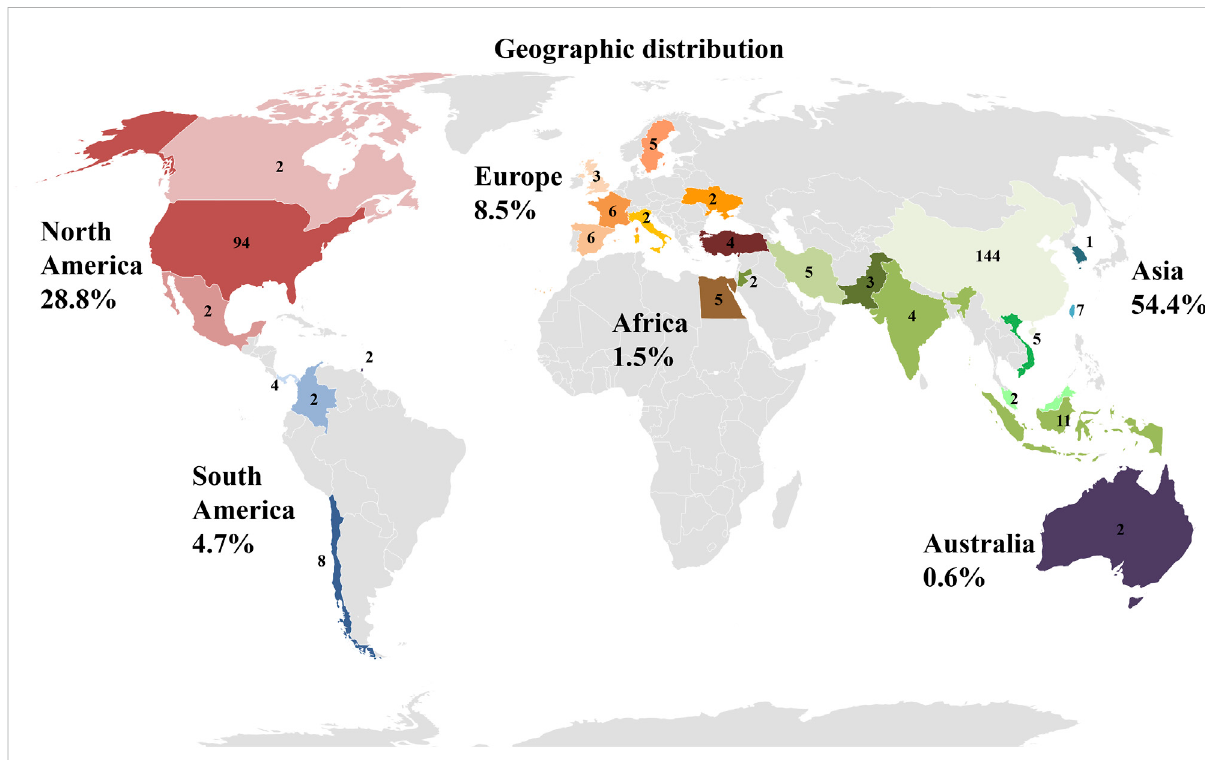
FIGURE 9 Location of clinical trials with PnD. The number of studies per country is indicated. In addition, the individual countries are grouped into geographical regions. Red colors stand for North America, bluefor South America, orange for Europe,brownfor Africa,green for Asia and purplefor Australia. The number indicates percentage of clinical trials with PnD on the different continents in the period under